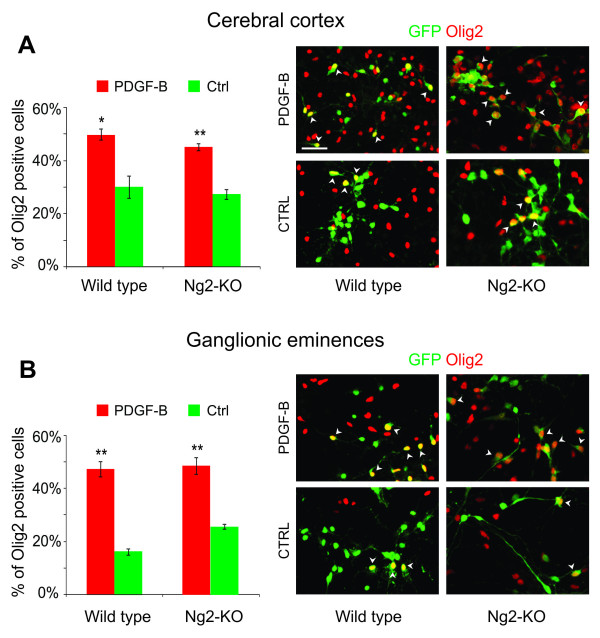
PDGF-B transduction induces an oligodendroglial fate in cultured neural progenitor cells. (A-B, left side) Histograms showing the percentage of Olig2-positive cells in PDGF-B (red bars) and control (green bars) transduced cortical (A) and GE (B) cultures obtained from wild type and NG2-KO embryos. (A-B, right side) Immunofluorescence micrographs of cortical (A) and GE (B) cultures derived from wild type and NG2-KO mice following the transduction with PDGF-B/GFP or control retroviruses. The immunoreactivity to Olig2 and GFP is shown in red and in green, respectively. NG2-KO cultures: nExp = 3; Wild type cultures: nExp = 2. *p < 0.05 and **p < 0.01 in a 2-tailed Student's t-test. Scale bar: 50 μm